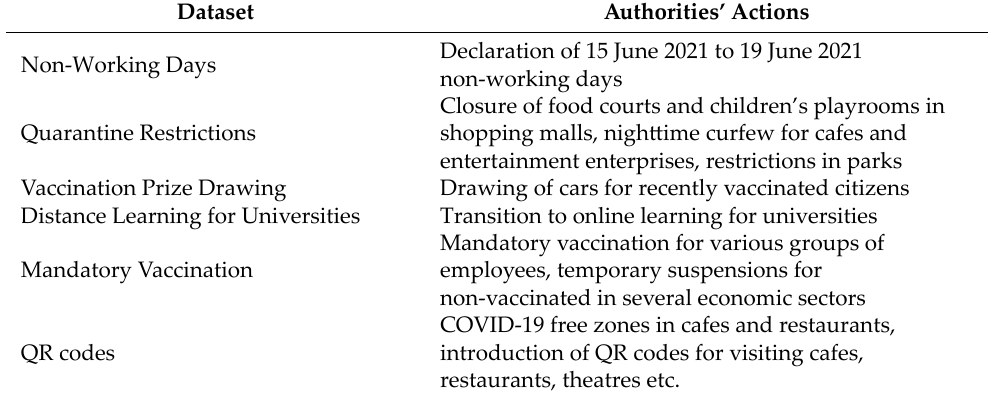
Table 1. Data Sets.